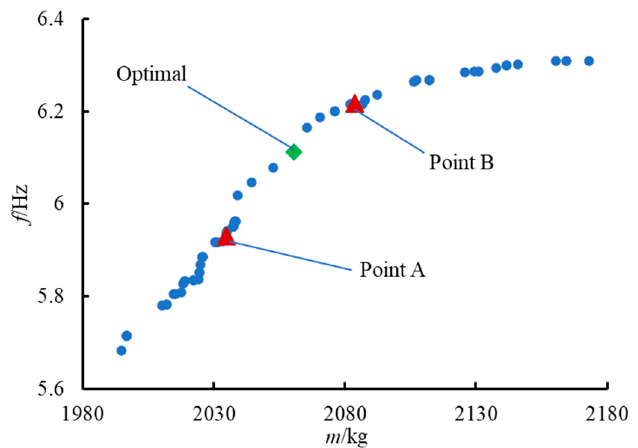
Figure 10. Pareto front.